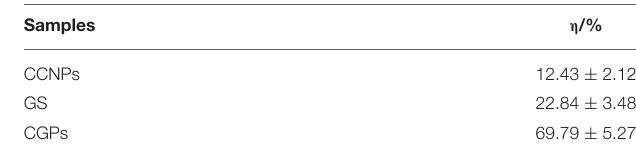
TABLE 2 | The inhibitory effects of CCNPs, GS, and CGPs on B. subtillis .